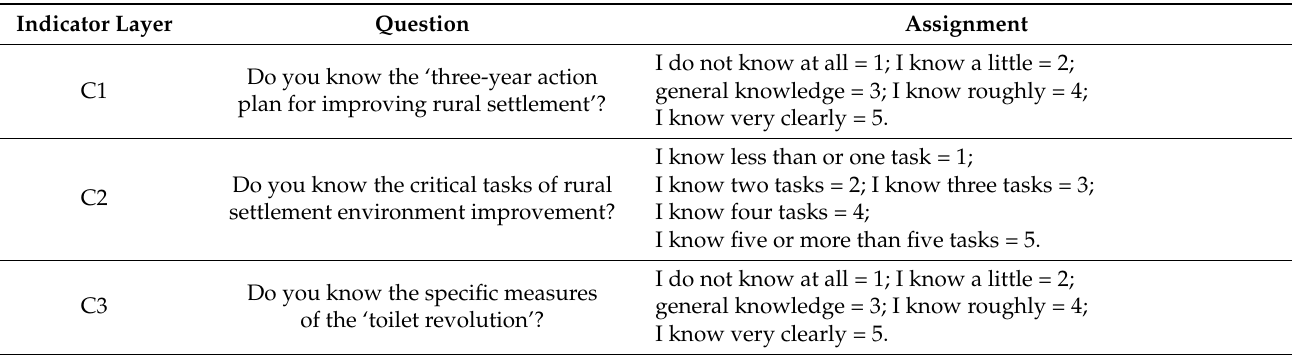
Table 2. Measurement of